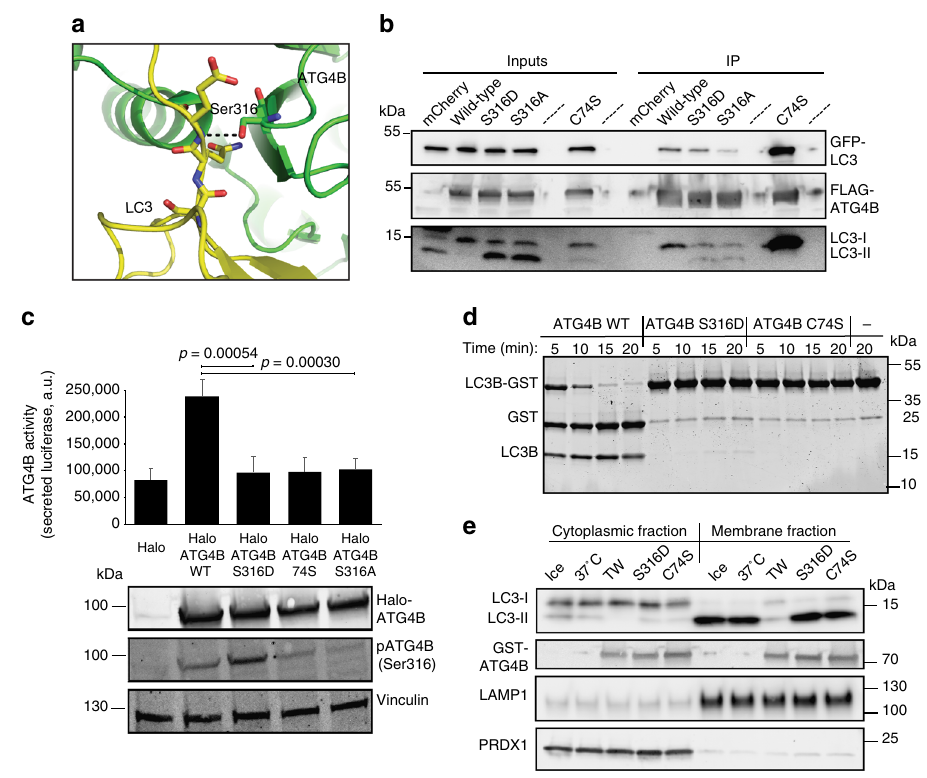
Fig. 3 ATG4B Ser316 phosphorylation reduces LC3 binding and inhibits its catalytic activity towards unprocessed and lipidated LC3 in vitro and in cells. a Overview of the ATG4B-LC3 co-crystal structure from PDB 2Z0E 24 , zooming at ATG4B Ser316 location. LC3 is in yellow and ATG4B is in green . Red and blue represent the oxygen and nitrogen atoms, respectively. Hydrogen bond is shown as a black dashed line . The molecular structure was generated with PyMOL. b HeLa cells stably expressing GFP-tagged LC3B were transfected with 3×FLAG-tagged ATG4B and ATG4B mutants or mCherry as control and subjected to immunoprecipitation with FLAG M2 af fi nity gel. The blots were probed for interaction of the 3×FLAG-tagged proteins with GFP-LC3B using GFP antibody ( upper panel ) and endogenous LC3B with LC3B antibody ( lower panel ), and 3×FLAG-ATG4B was detected using FLAG antibody ( middle panel ). c ATG4B activity was measured in the Actin-LC3-DelN reporter cell line 48 h after transfection with the WT, catalytic inactive (C74S), phosphomimetic (S316D) and non-phosphorylatable (S316A) Halo-ATG4B constructs ( n = 3, average ± s.d., and representative blot showing the correct expression of the constructs). Values displayed are the relative intensity of phosphorylated ATG4B Ser316 normalized to Halo-ATG4B, relative to WT